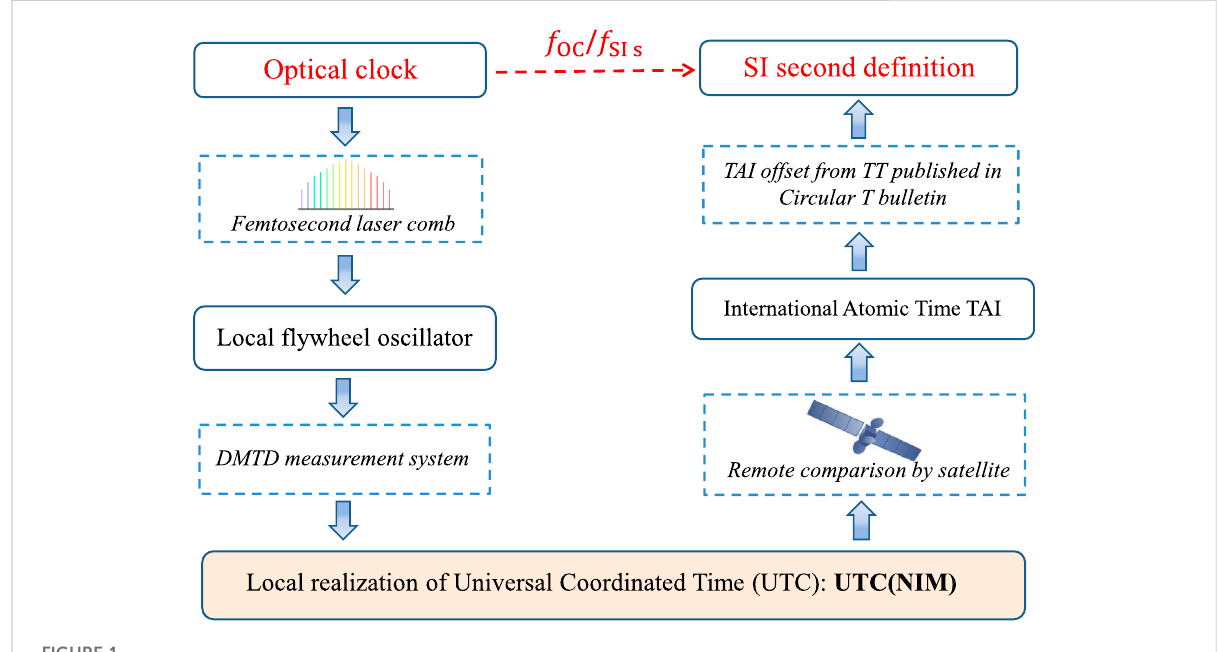
FIGURE 1 Schematic of optical frequency